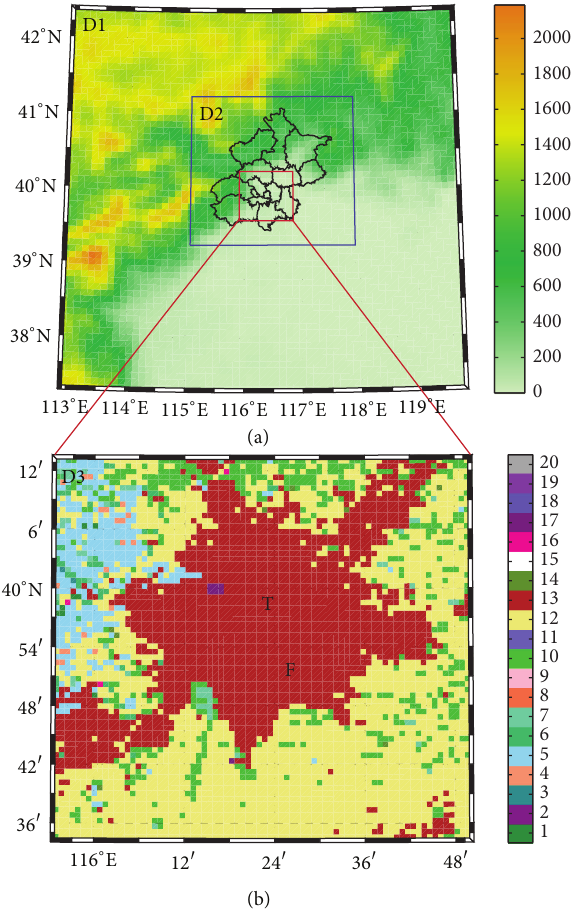
Figure 2: (a) Domain configuration of the WRF model simulation with terrain height (shaded, unit: m). (b) Land use/land cover in the innermost domain. The red color points to the urban and built-up areas, and the yellow color represents the croplands. The text “T” and “F” indicate the location of Beijing 325 m Meteorological (B325) Tower and Fangzhuang,